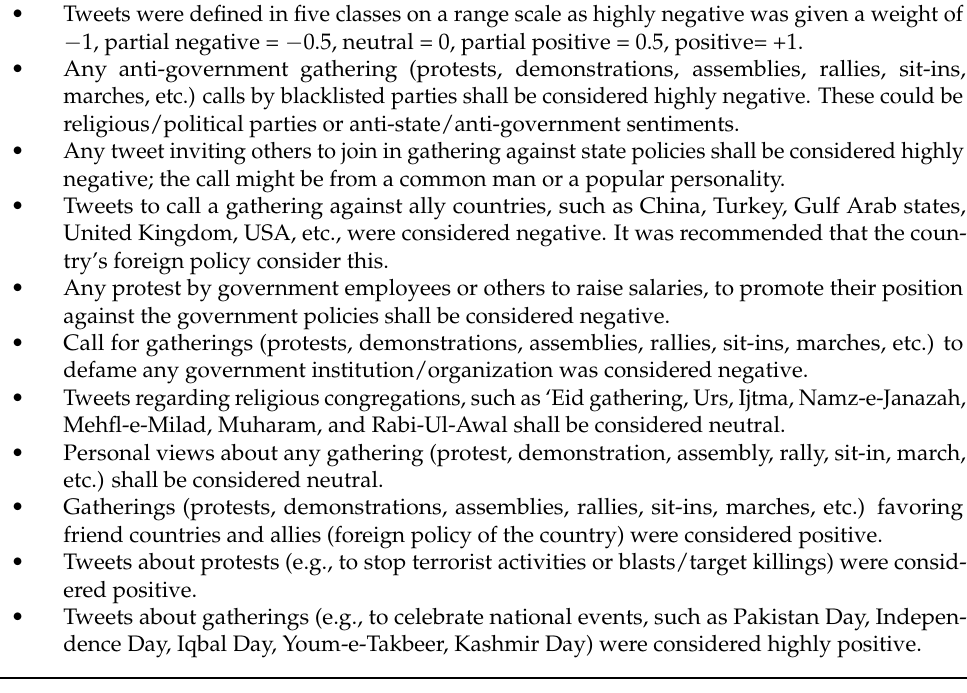
Table A3. Annotation guidelines for the Twitter data set in Roman